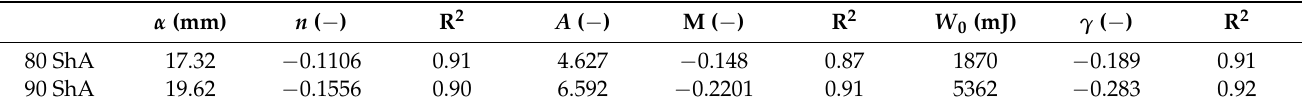
Figure 18. Fatigue data for R = 0 represented by W s –N energy approach (80 ShA and 90 ShA). Statistical fitting and analyses were performed in Graphpad PRISM environment. All results are collected in Table 4. Table 4. Fatigue models data fitting for 80 ShA and 90 ShA.